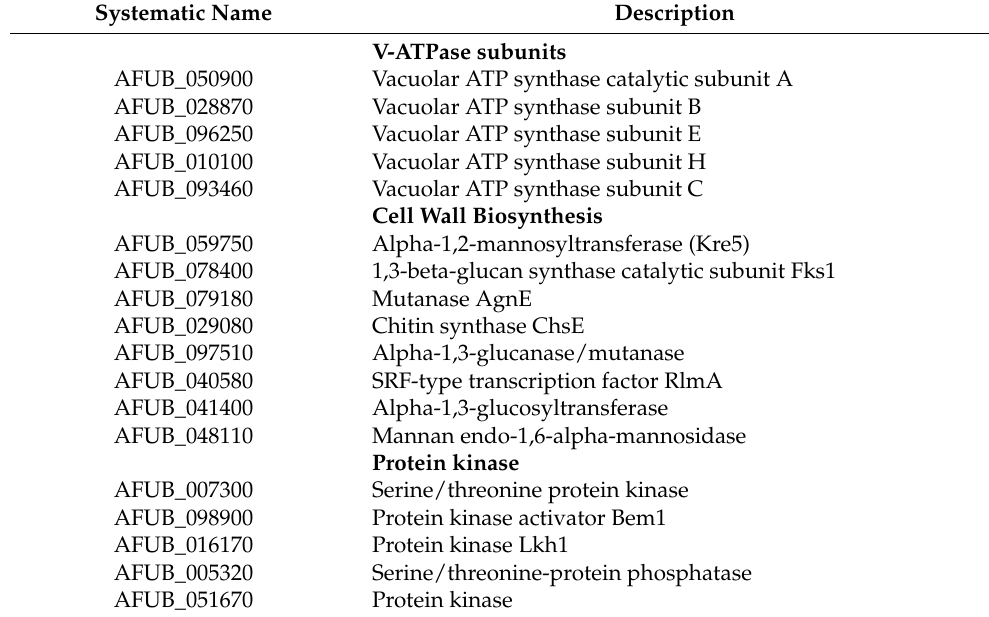
Table 1. Selected Members of VmaC interacting